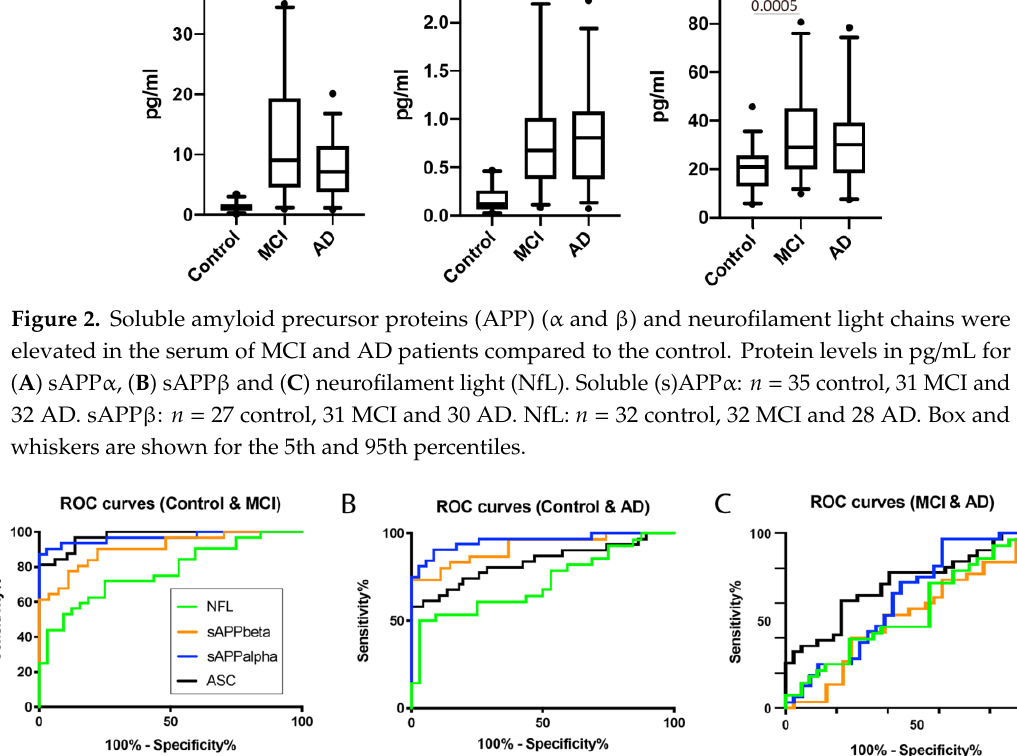
Figure 3. ASC is a promising serum biomarker of MCI. Receiver operator characteristic (ROC) curves for NfL (green), sAPPβ (orange), sAPPα (blue) and ASC (black). ( A ) Control vs. MCI, ( B ) control vs. AD and ( C ) MCI vs. AD.